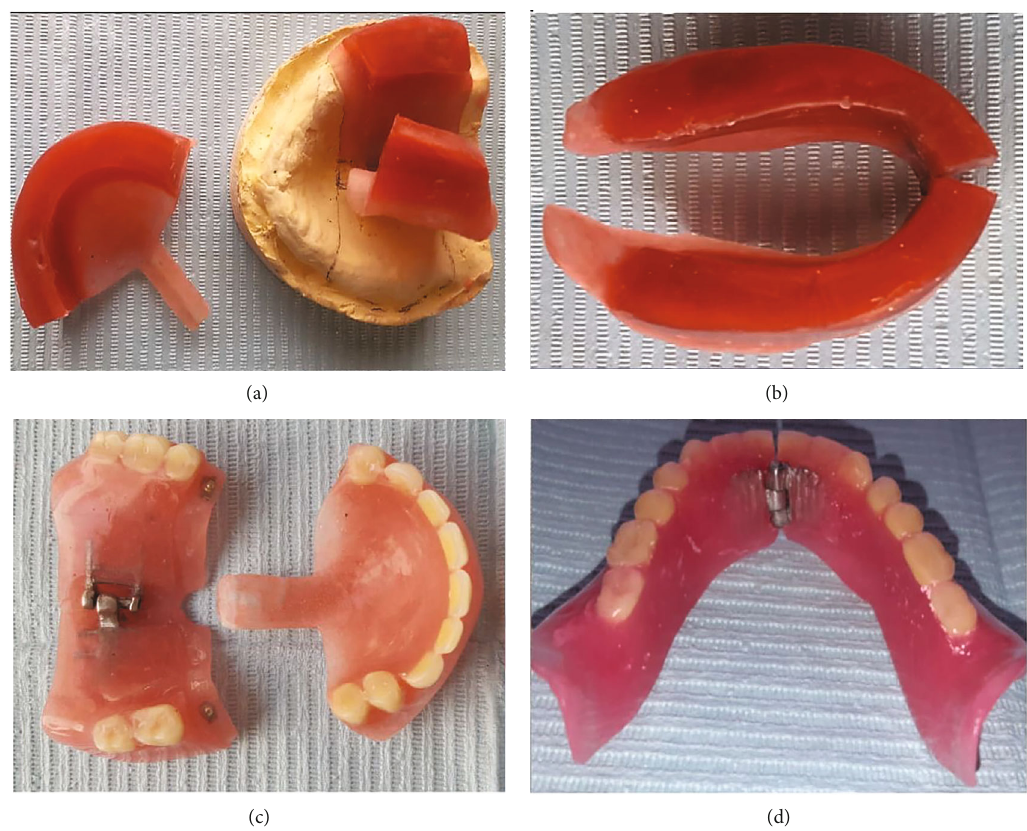
Figure 2: (a) Maxillary trial denture base and occlusion rim with custom-made hinge at midline of posterior segment. (b) Mandibular trial denture base and occlusion rim. (c) Sectioned maxillary prosthesis. (d) Sectioned mandibular